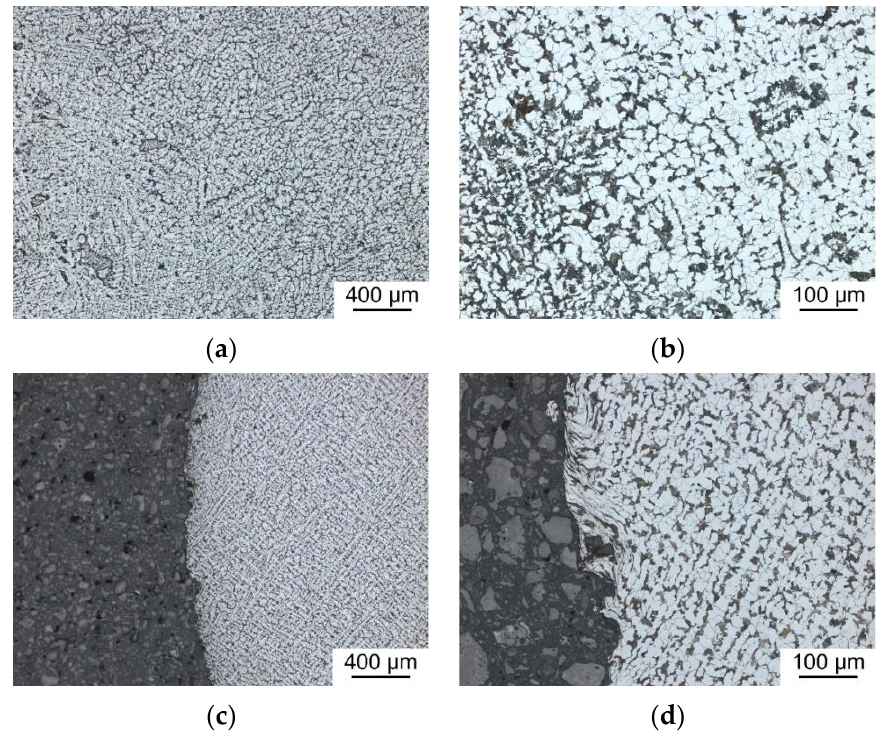
Figure 5. Polished cross-section of sandblasted (I) specimen, ( a , b ) microstructure of the center area, ( c , d ) microstructure of the edge area.